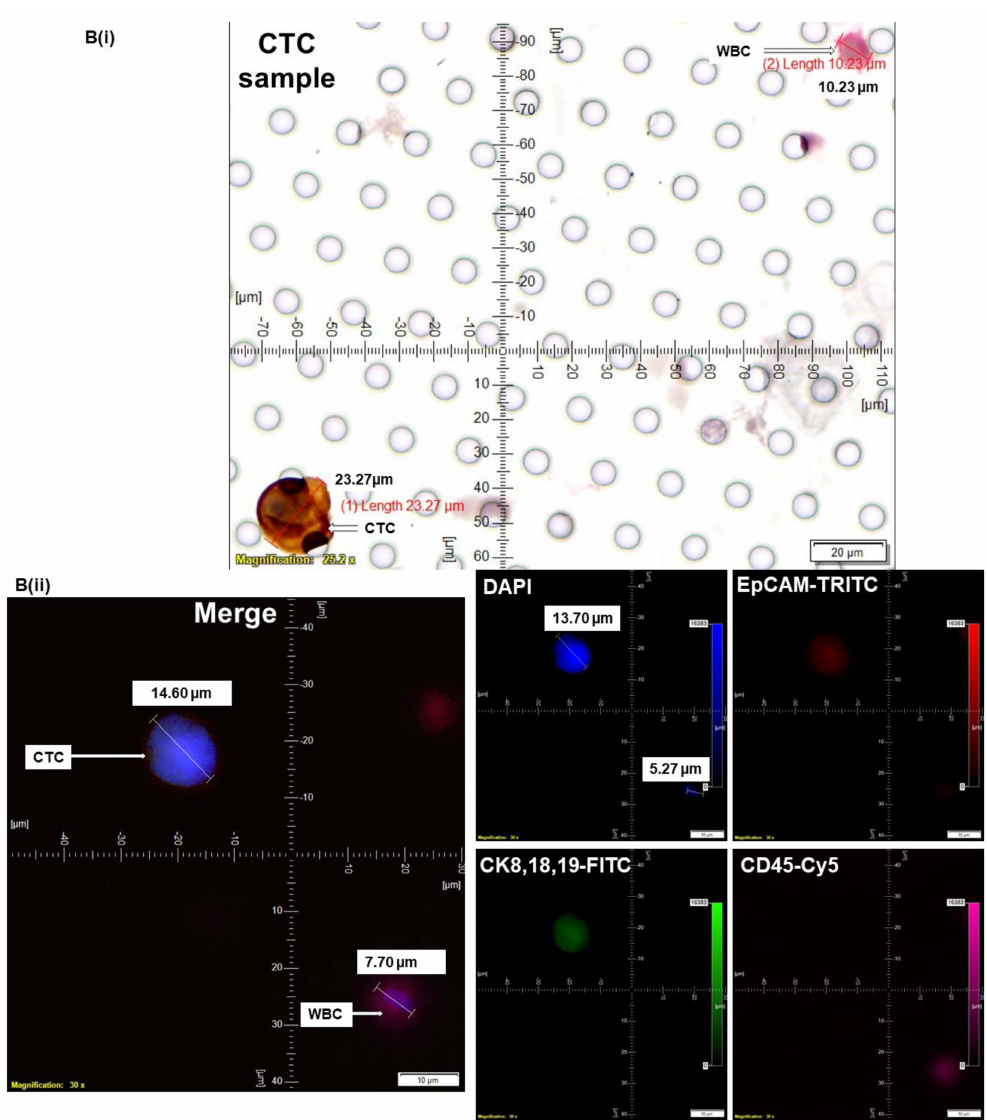
Figure 4. Determining CTC by ICC × 2 in endometrial and ovarian cancers: CTCs were captured from blood samples from patients with endometrial ( A ) and ovarian ( B ) tumors and enumerated using ICC × 2 ( Ai , Bi ). Blood samples were spiked (Spiked samples) with titrating number (250